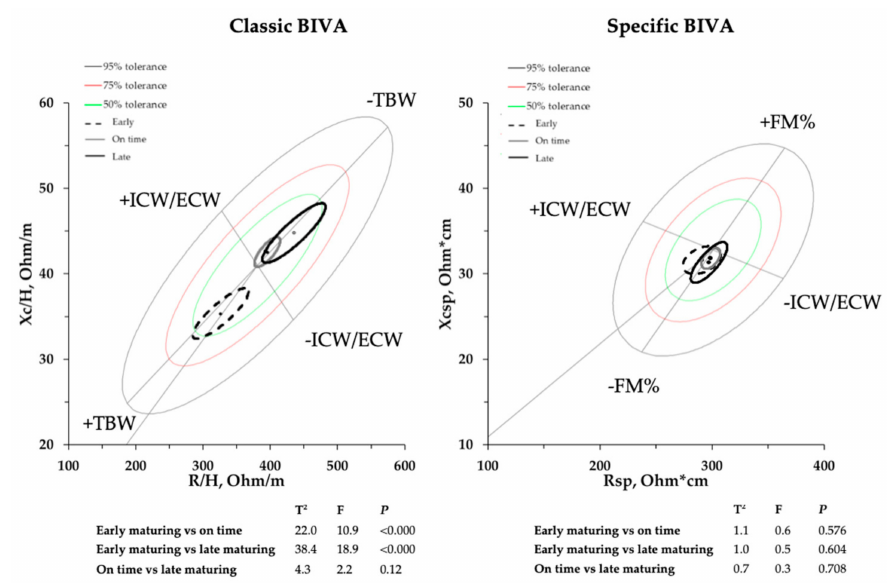
Figure 1. Main graph with 95% confidence ellipses plotted on the new reference ellipses; Hotelling’s T 2 test results are included.